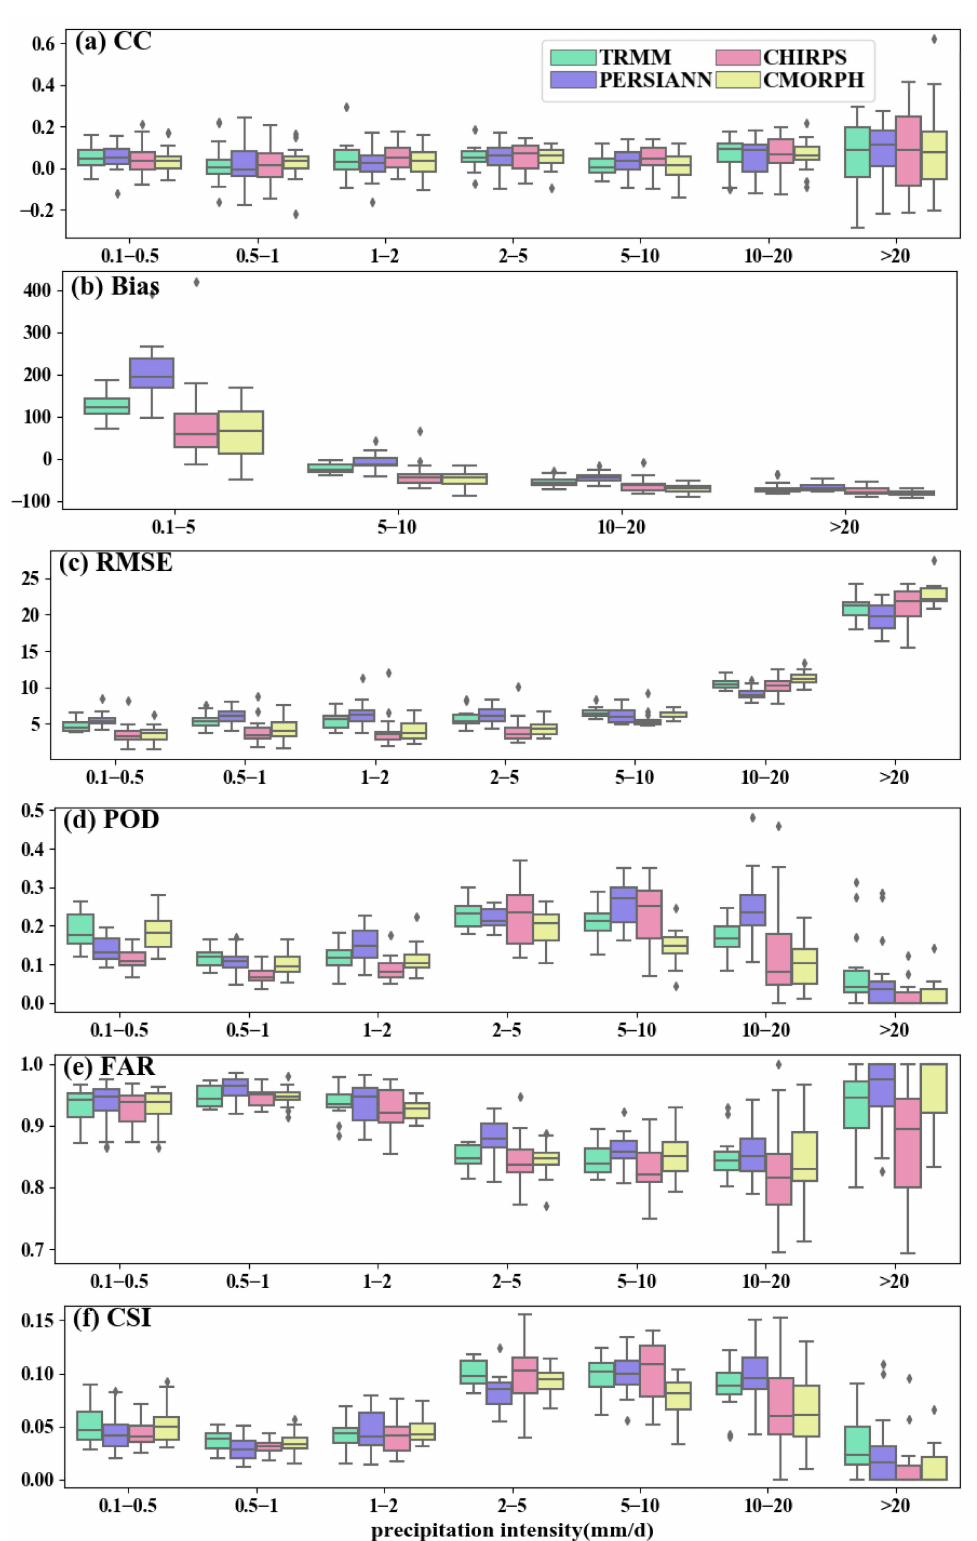
Figure 9. Box plots of the statistical metrics of daily precipitation for different precipitation intensity intervals: ( a ) CC, ( b ) Bias, ( c ) RMSE, ( d ) POD, ( e ) FAR, and ( f ) CSI. Each box ranges from the lower quartile (25th) to the upper quartile (75th). The middle line indicates the median value in the box. The whiskers show the largest and smallest values within 1.5 times the interquartile range. The diamond presents the points beyond the